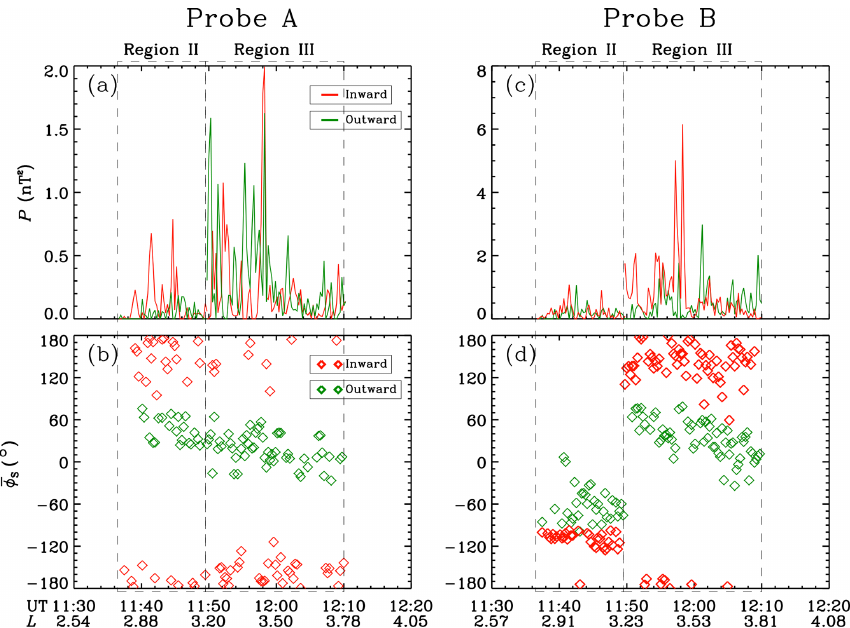
Figure 3. Quantitative comparison of wave properties between probe A and probe B. (a, c) Total magnetic field power P . (b, d) Spectrum- weighted averaged azimuthal angle of Poynting flux φ S